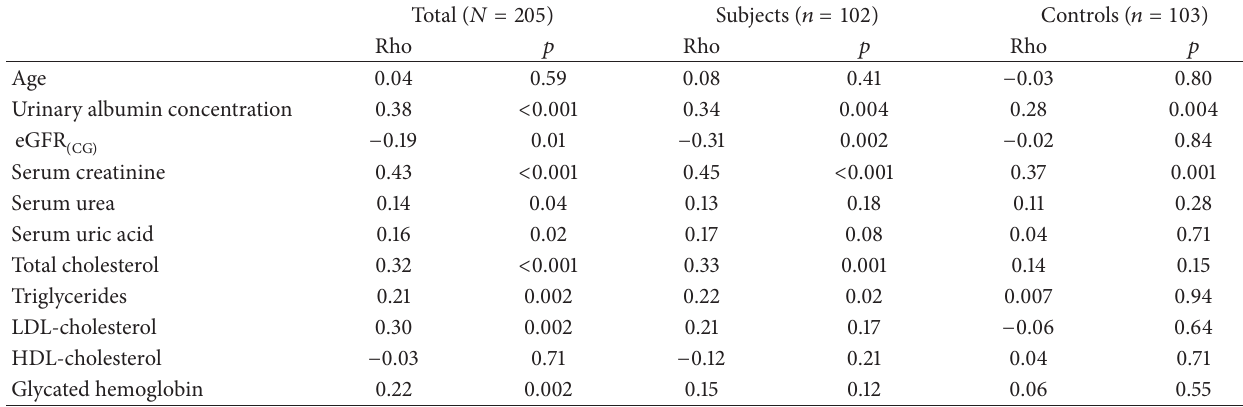
Table 3: Correlation of 𝛽 2m with selected parameters in subjects and